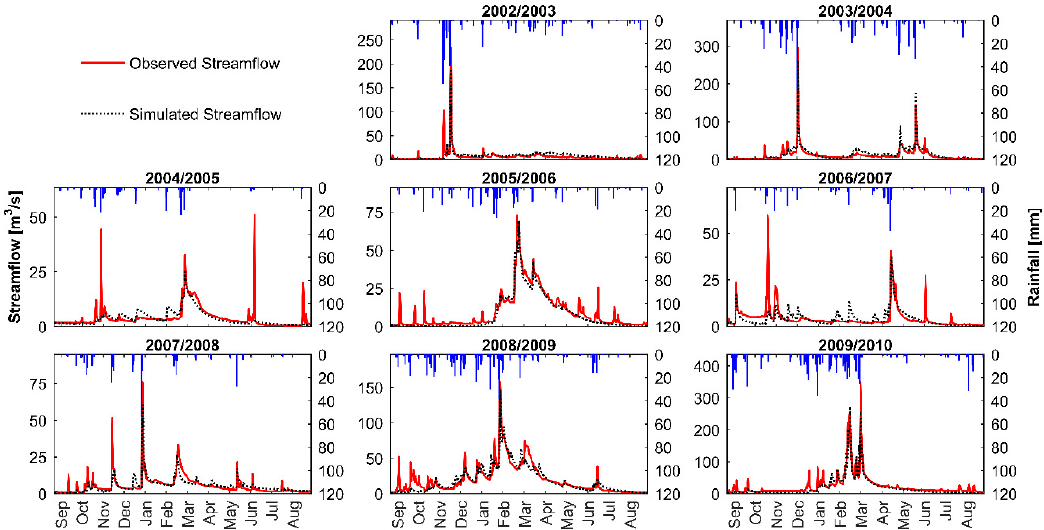
Figure 4. Daily streamflow simulated using the annual optimal parameter combinations obtained during calibration.